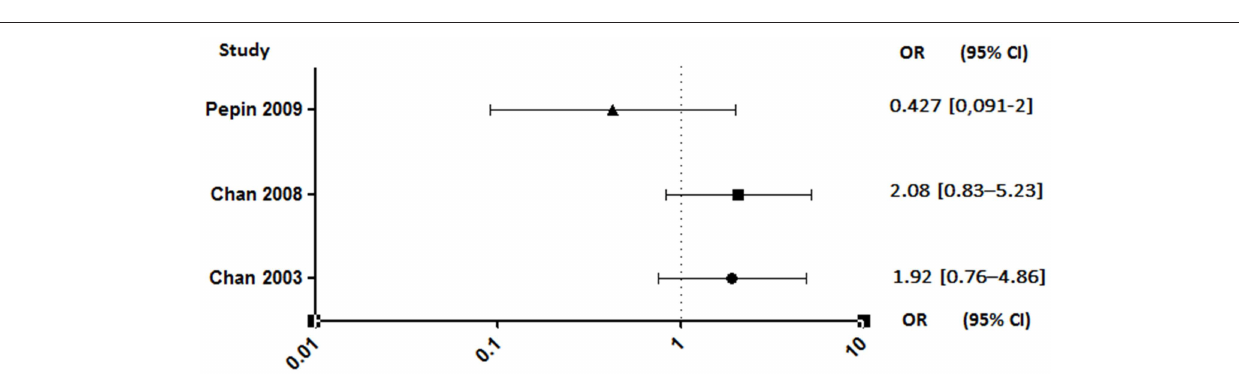
FIGURE 7 | Hemorrhagic risk between aspirin and no aspirin users. Odds ratio (OR), 95% confidence interval (95% CI) (4, 92,